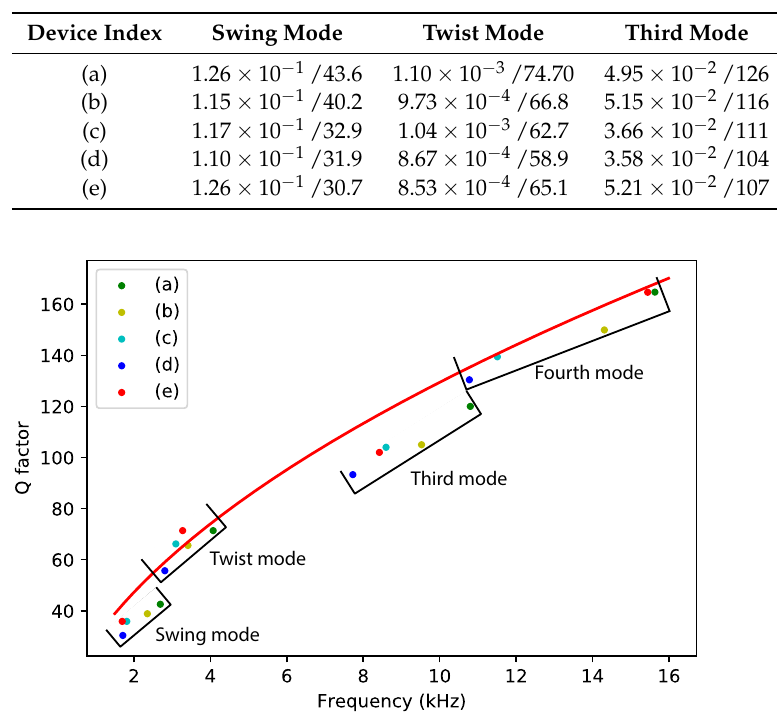
Table 4. Calculated R kinetic (21) / calculated Q factor (22) for different devices and vibration modes.